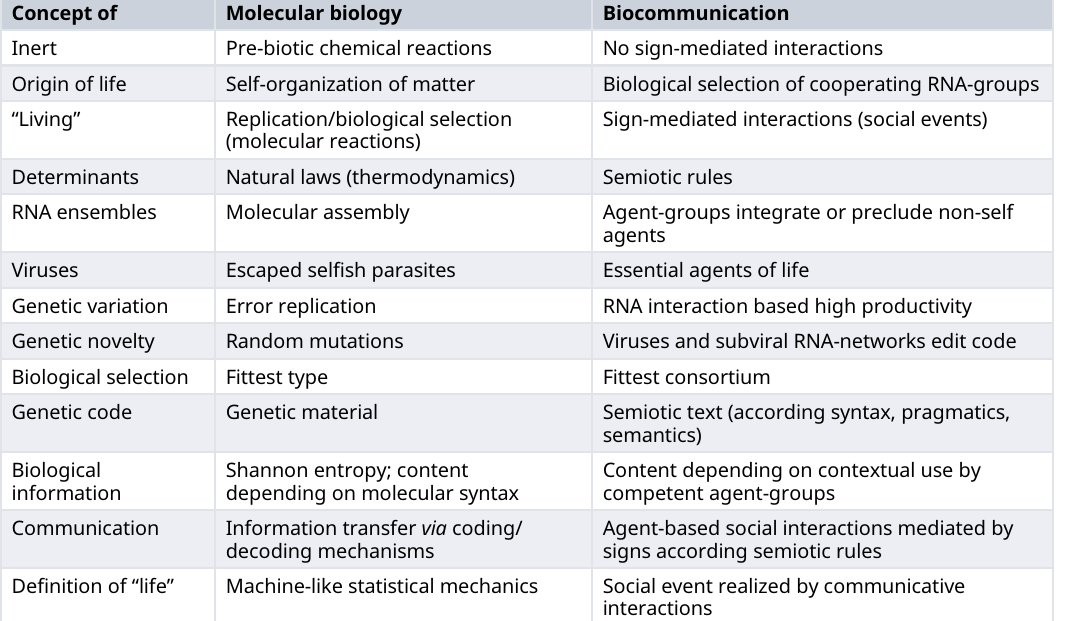
Table 1. Different paradigms explaining and understanding life (reworked from Witzany,